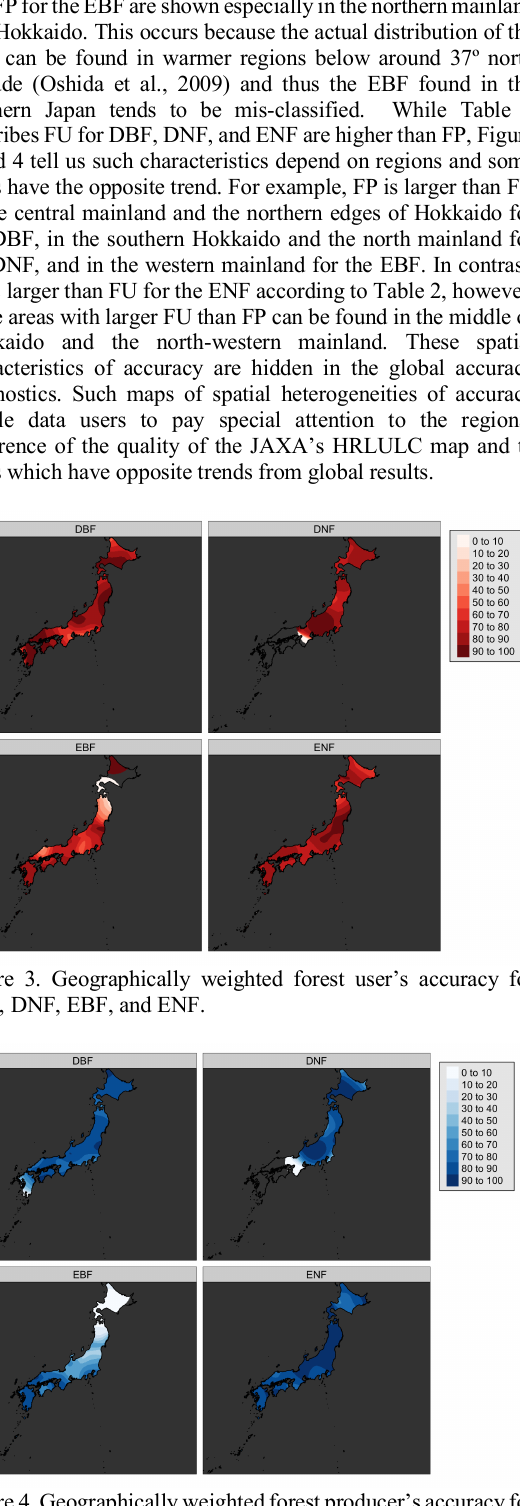
Figure 4. Geographically weighted forest producer’s accuracy for DBF, DNF, EBF, and